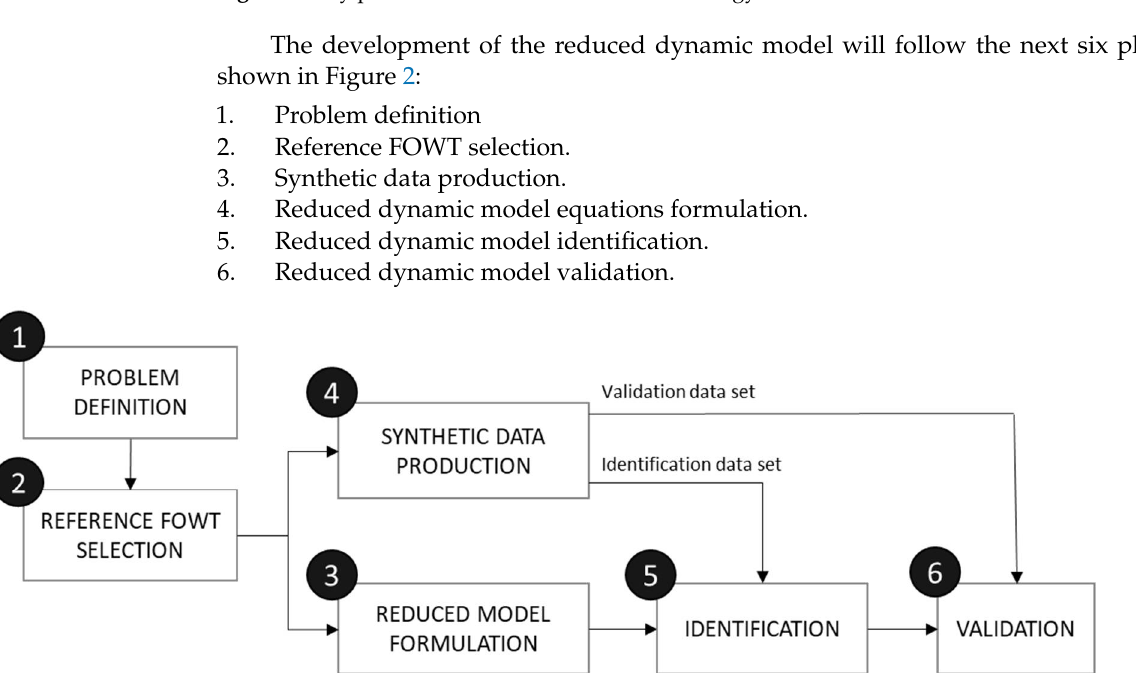
Figure 1. Key points of the identification methodology.